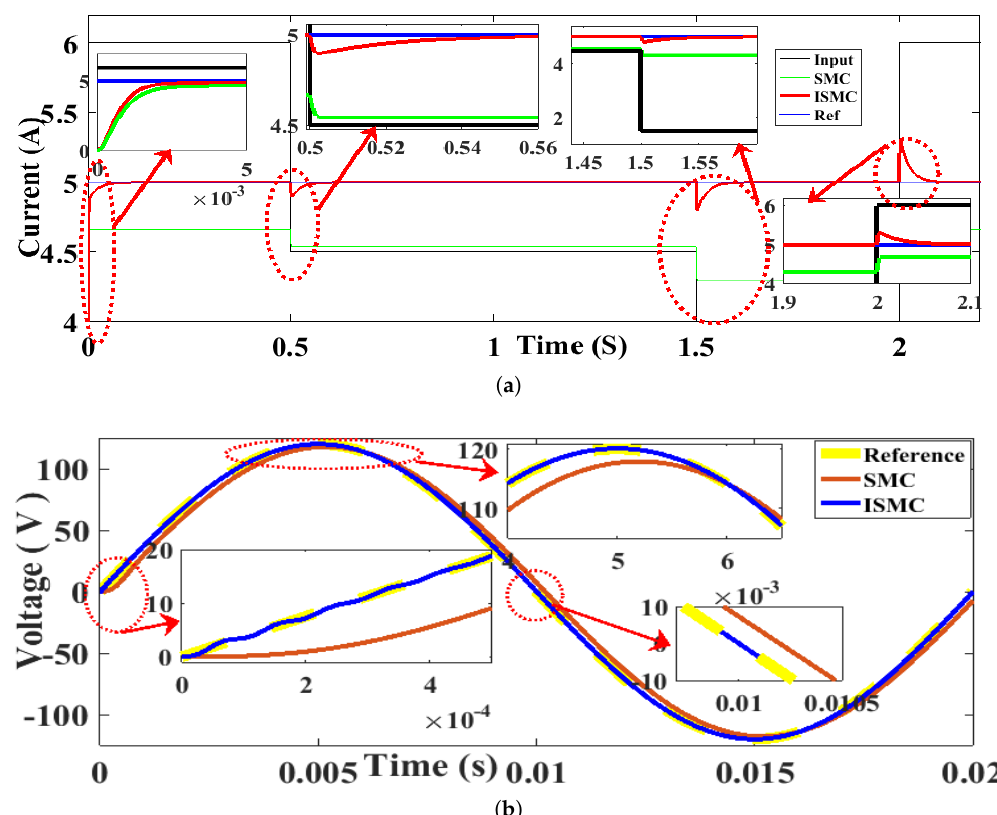
Figure 4. Performance comparision of SMC and ISMC: ( a ) Input current, ( b ) Output